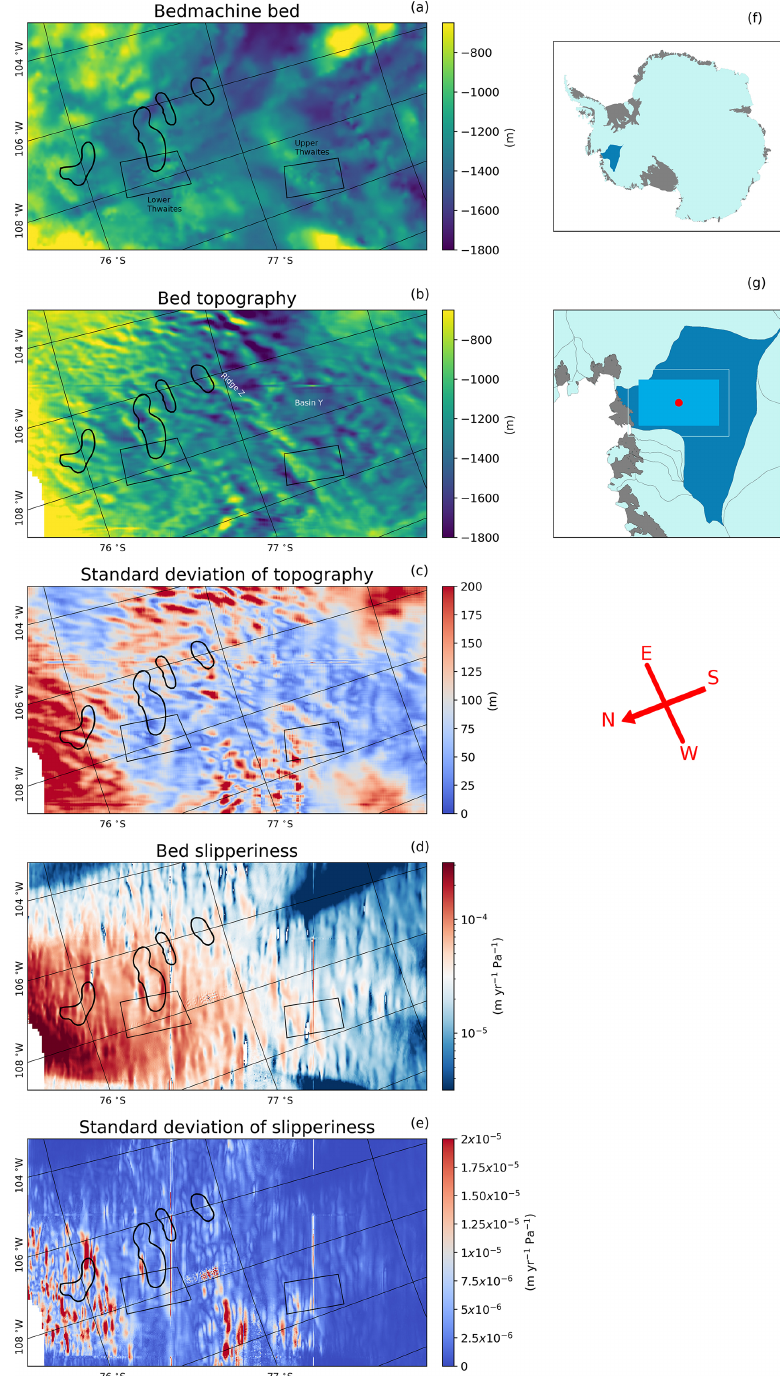
Figure 5. Inversion outputs across a 160km by 280km region of Thwaites Glacier (location shown in panels f and g ). The compass directions shown are accurate at the centre of the region (red dot in panel g ) but may vary by up to 10 ◦ across the region due to the polar stereographic projection. (a) Bed topography from BedMachine Antarctica (Morlighem et al., 2020) and (b) bed topography, (c) standard deviation of bed topography, (d) bed slipperiness and (e) standard deviation of bed slipperiness from our inversions of REMA (Howat et al., 2019) and ITS_LIVE (Gardner et al., 2018) at 120m resolution. Standard deviations are a measure of variability between overlapped patches and should not be interpreted as a measure of the error in the bed topography or bed slipperiness. Black rectangles depict regions of pre-existing highly resolved bed topography (Holschuh et al., 2020) examined in Fig. 6. The four subglacial lakes observed from surface altimetry changes by Smith et al. (2017) are also outlined in